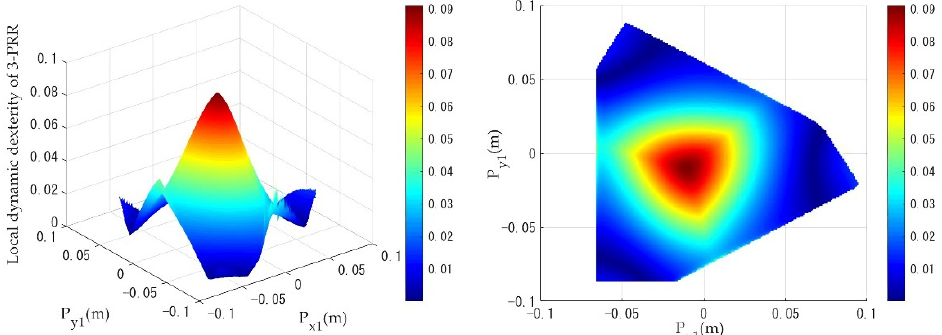
Figure 13. Distribution of the local dynamic dexterity of the 3-PRR PPM under a linear trajectory.